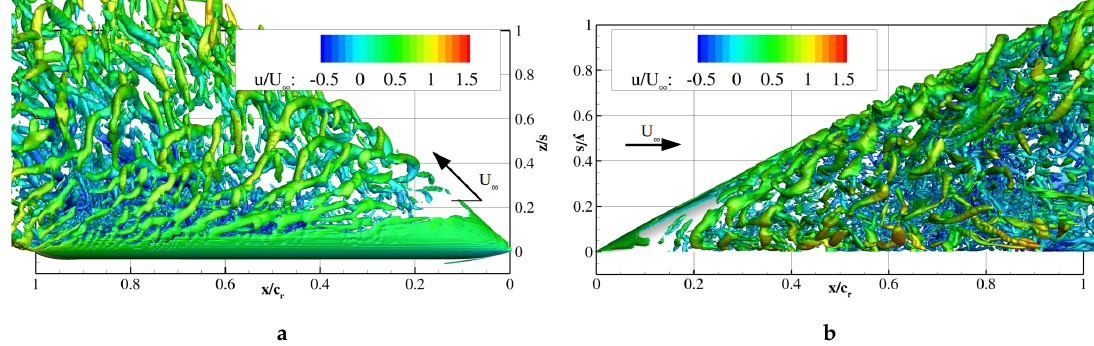
Figure 10. Computed Q-criterion Q = 10 5 s − 2 colored by the relative axial velocity; α = 45 ◦ , Re = 0.5 × 10 6 ; ( a ) side view and ( b ) top